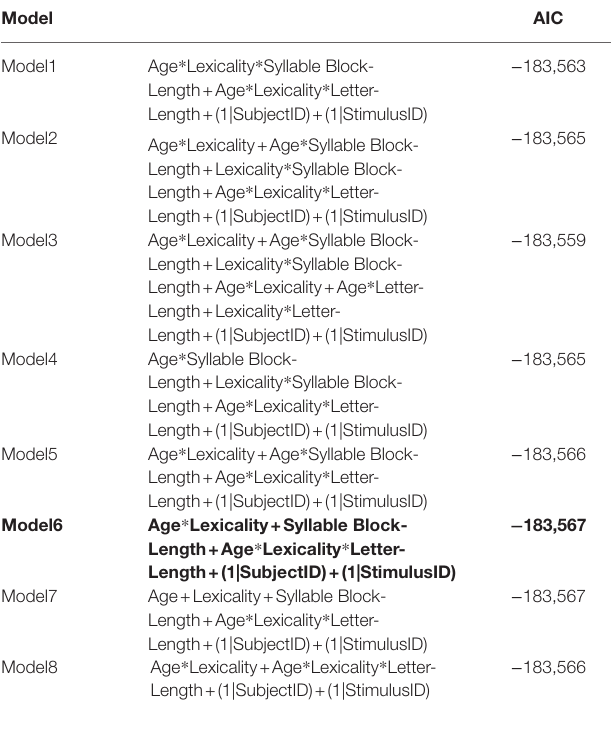
TABLE 6 | Comparison of mixed-effects regression models on reading latency: age × lexicality × length (best-fitting model in bold). Model